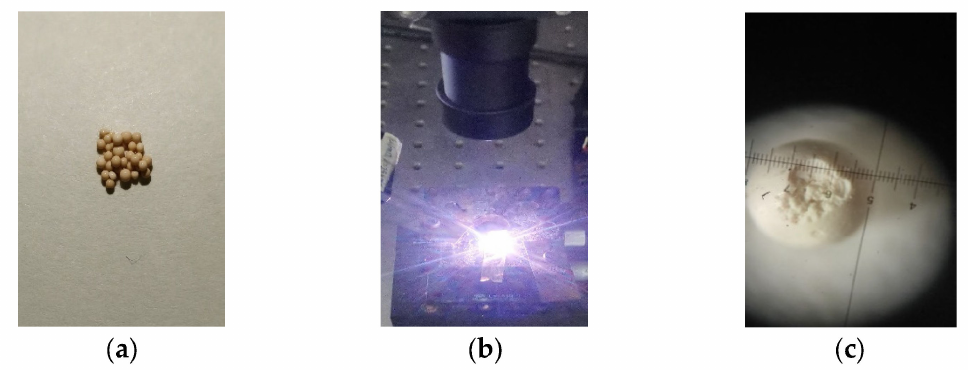
Figure 3. LIBS test samples. ( a ) Chelating resin before LIBS applicability. ( b ) LIBS interaction with sample. ( c ) Chelating resin after LIBS